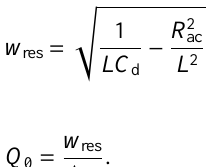
Figure 3. Cross section microscopic view of a micro coil with 7 layers.